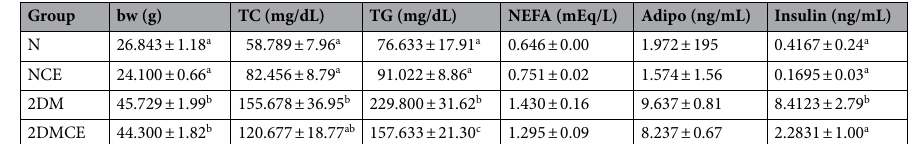
Table 1. Effects of cinnamon extract on body weight (bw) and plasma parameters. Values are expressed as mean ± SD, n = 3/group. The alphabetical symbols a, b, and c on the right shoulder of the number indicate intergroup comparisons. Different superscript letters indicate statistically significant differences among groups ( P < 0.05). N: nondiabetic normal control group. Mice were orally administered 1-mL pure water for 8 weeks.